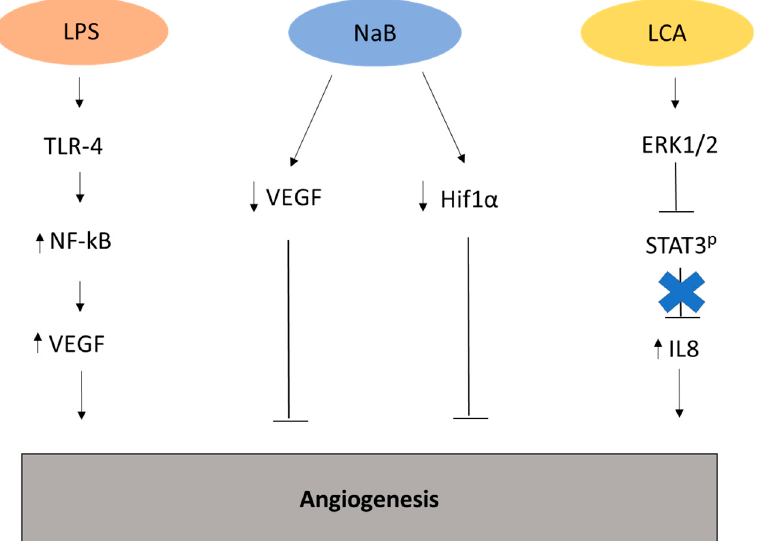
Figure 2. Representation of the metabolites and related pathways involved in angiogenesis in cancer. Lipopolysaccharide (LPS) can stimulate the generation of new vasculature through the upregulation of vasculature endothelial growth factor (VEGF) [28]. Conversely, the metabolite sodium butyrate (NaB) inhibits angiogenesis by modulating the expression of VEGF and hypoxia-inducible factor (HIF)-1 α in colon cancer cell line HT29 [33]. Lithocolic acid (LCA) promotes angiogenesis by upregulating extracellular signal-regulated kinases (Erk)1/2, driving to the suppression of Signal transducer and activator of transcription 3 (STAT3) phosphorylation and enhanced expression of interleukin (IL)-8 in colorectal cancer cell line HCT116 [34].